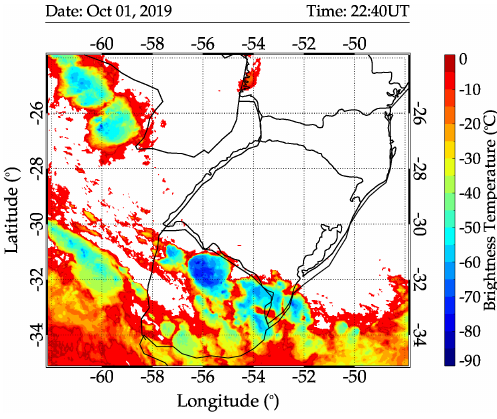
Figure 6. GOES-16 IR image taken at 22:40UT showing the CGW- generating MCS over